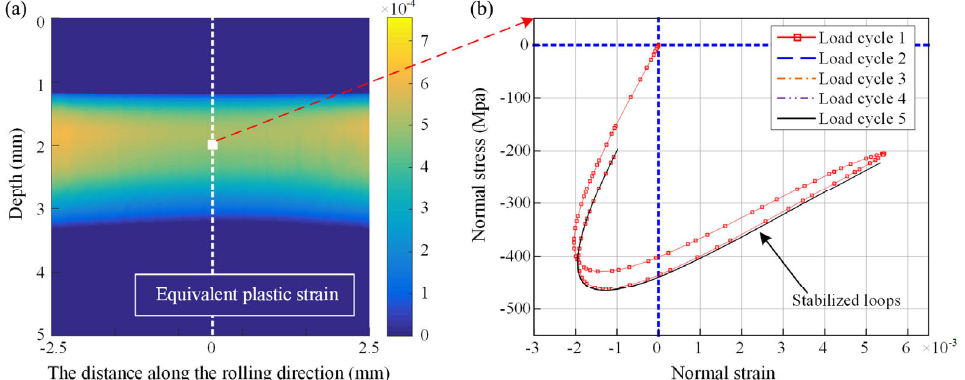
Fig. 9 Equivalent plastic strain after a steady stress–strain response is achieved (a) and the stress–strain response at the depth of 2 mm (b).